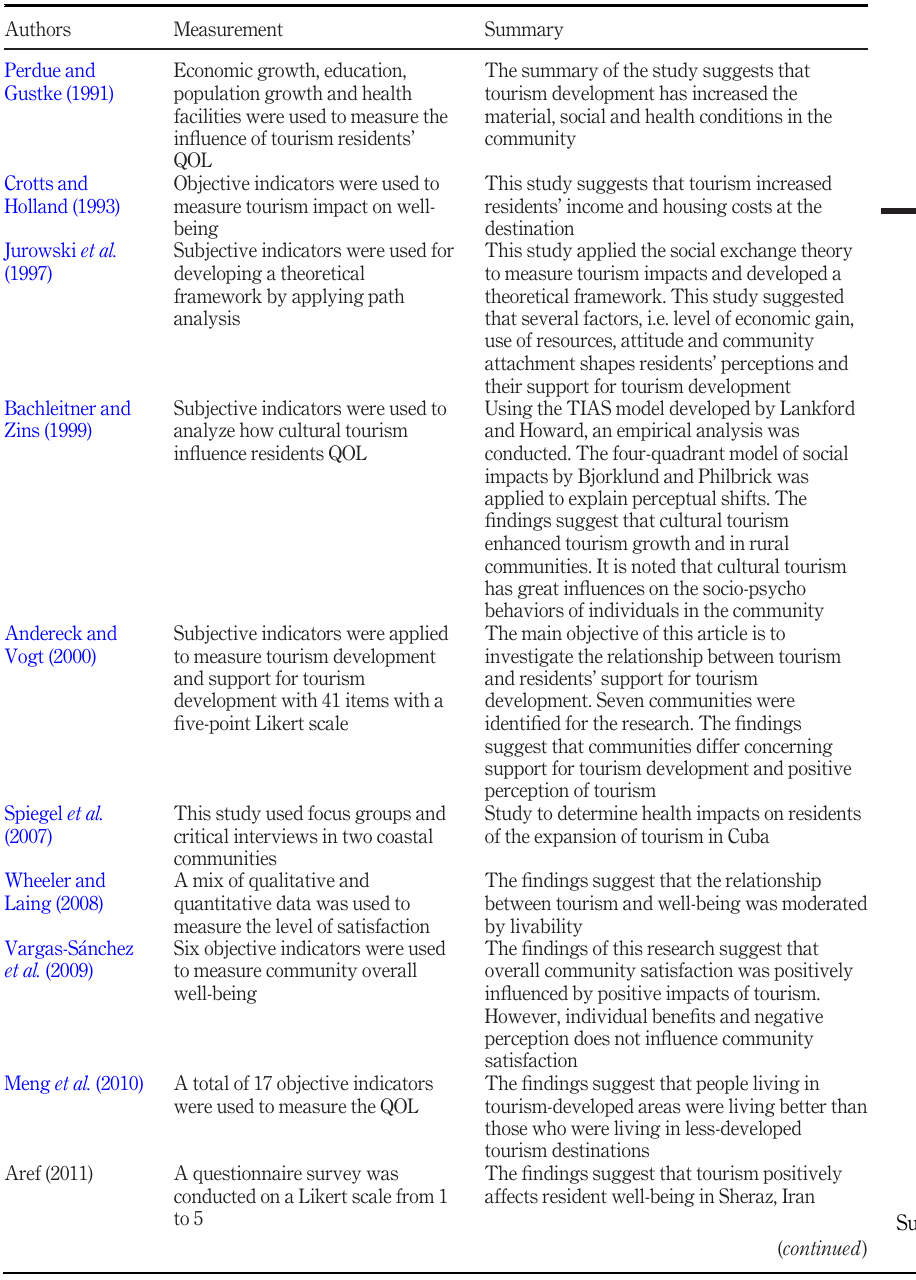
Table 1. Summary of